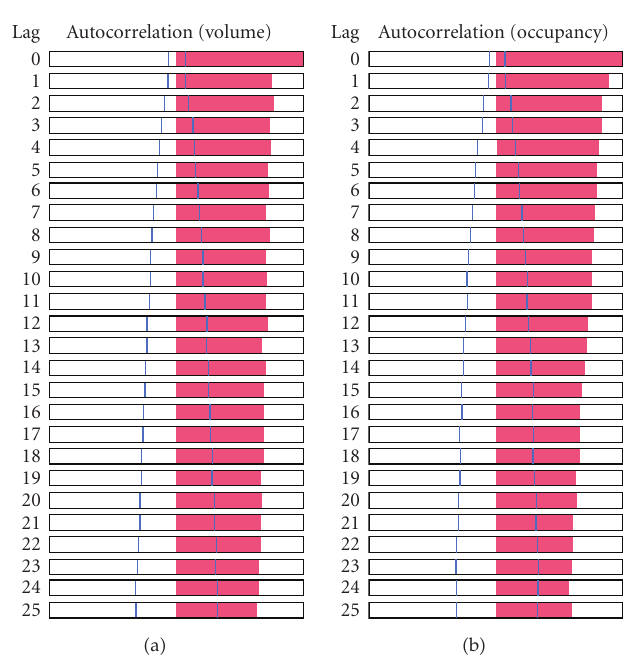
Figure 2: Autocorrelation function of the time-series of volume and occupancy.